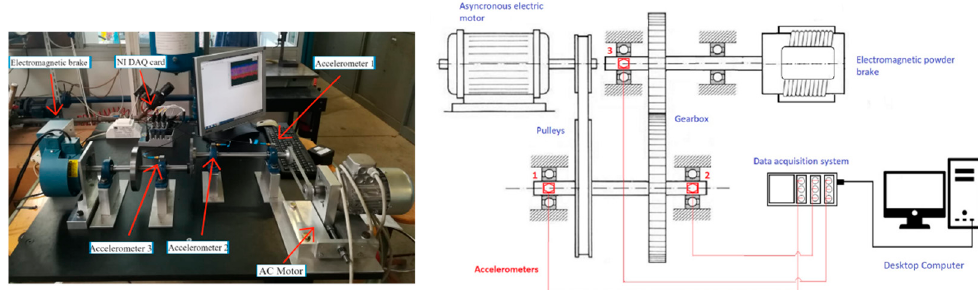
Figure 3. The test rig ( left ) and its mechanical scheme ( right ). Table 1. Dataset Description.